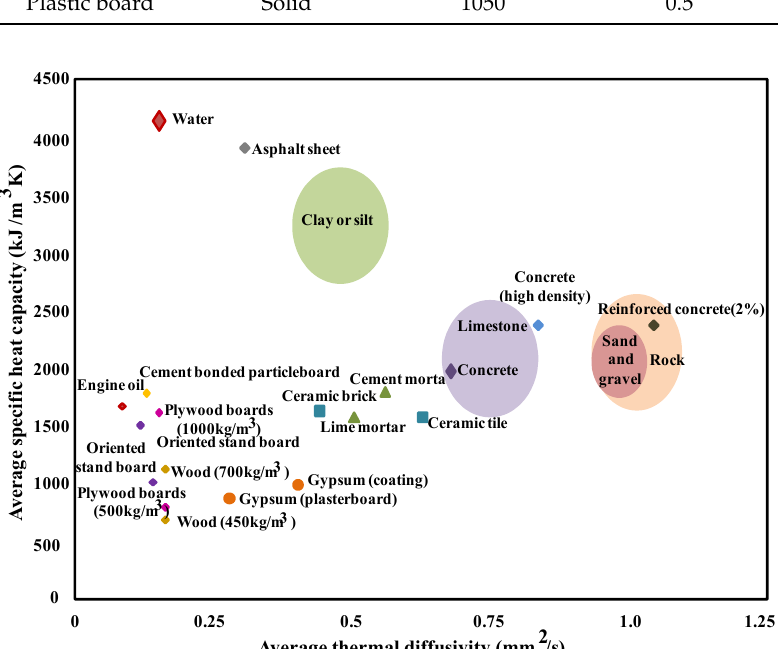
Figure 6. Most available and common SHSMs, reprinted/adapted with permission from Ref. [18], 2022, Elsevier.